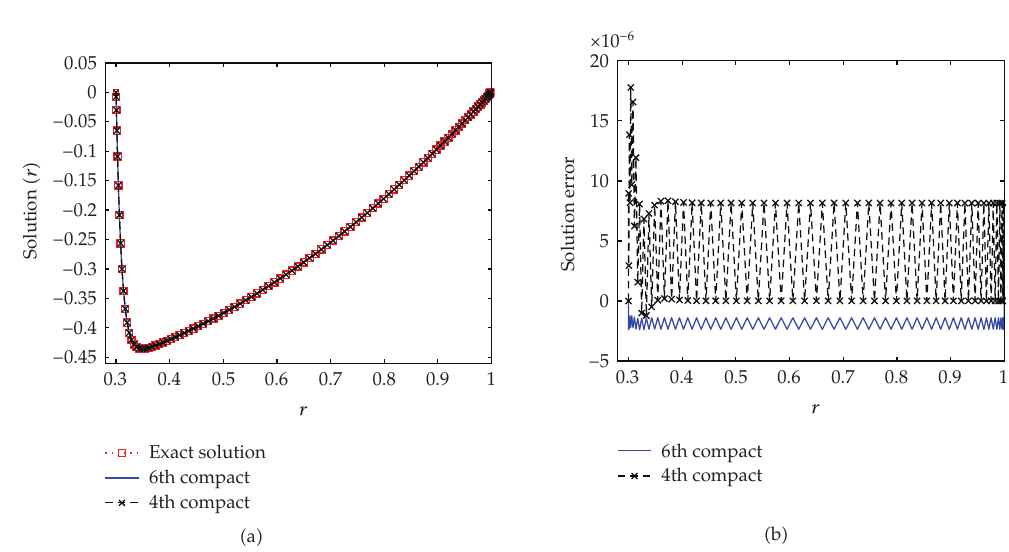
Figure 1: (cid:6) a (cid:7) Solutions of the benchmark problem 1. (cid:6) b (cid:7) Solution errors of the sixth- and fourth-order compact schemes. The total grid points were N (cid:9) 100 and the parameter was (cid:5) (cid:9) 0 . 01.